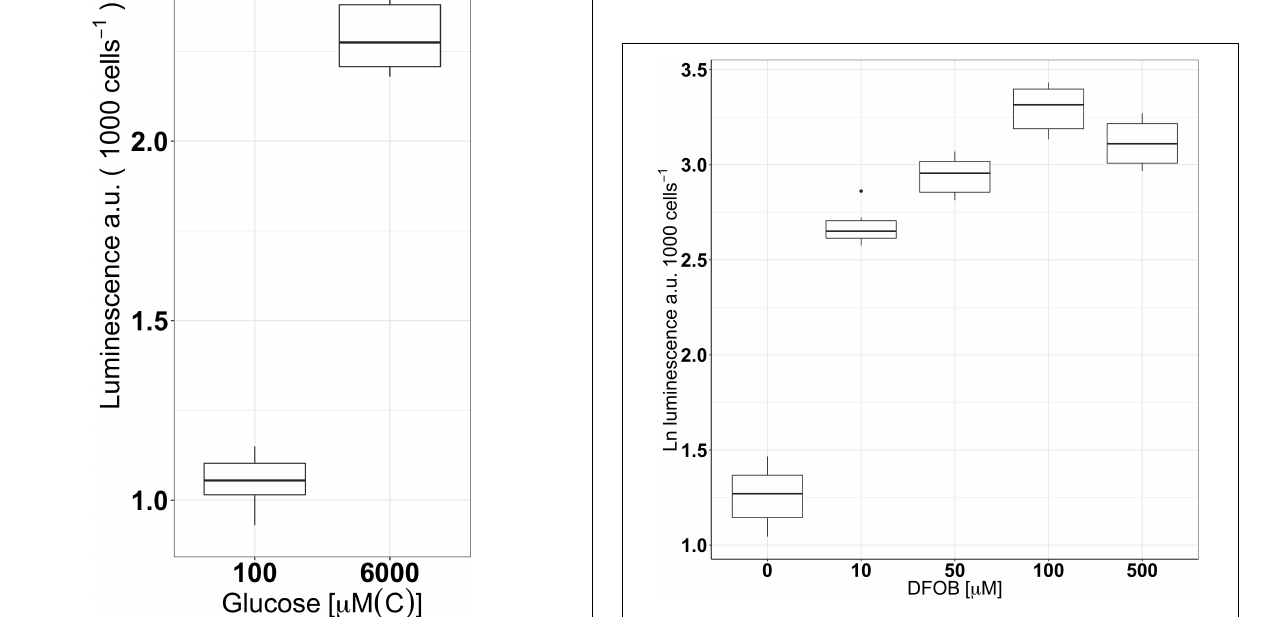
FIGURE 3 | Expression of icl as luminescence per 1000 cells of icl-luc grown under two different concentration of glucose (100 µ M[C] and 6 mM[C]) in Fe-replete conditions using six replicates per condition. Outliers are marked as dots and a.u denotes arbitrary units for luminescence.